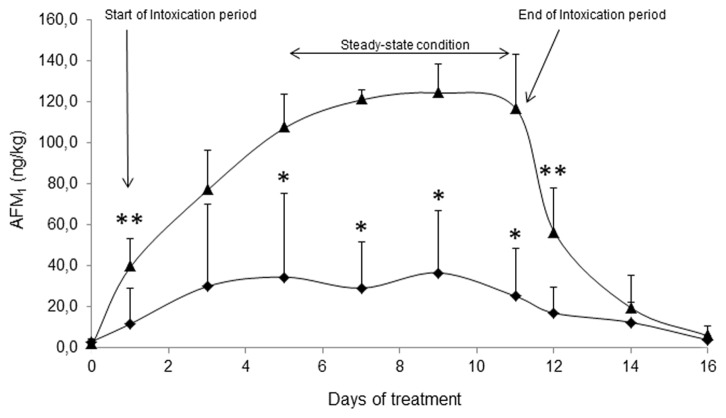
Average AFM1 concentration in milk.Six vaccinated (⧫) and six unvaccinated control (▴) cows were fed 102 μg of AFB1/day from day 1 to day 11. Data are presented as mean ± SD. Within each day, differences between vaccinated and control cows are marked (**P<0.10, *P<0.05).